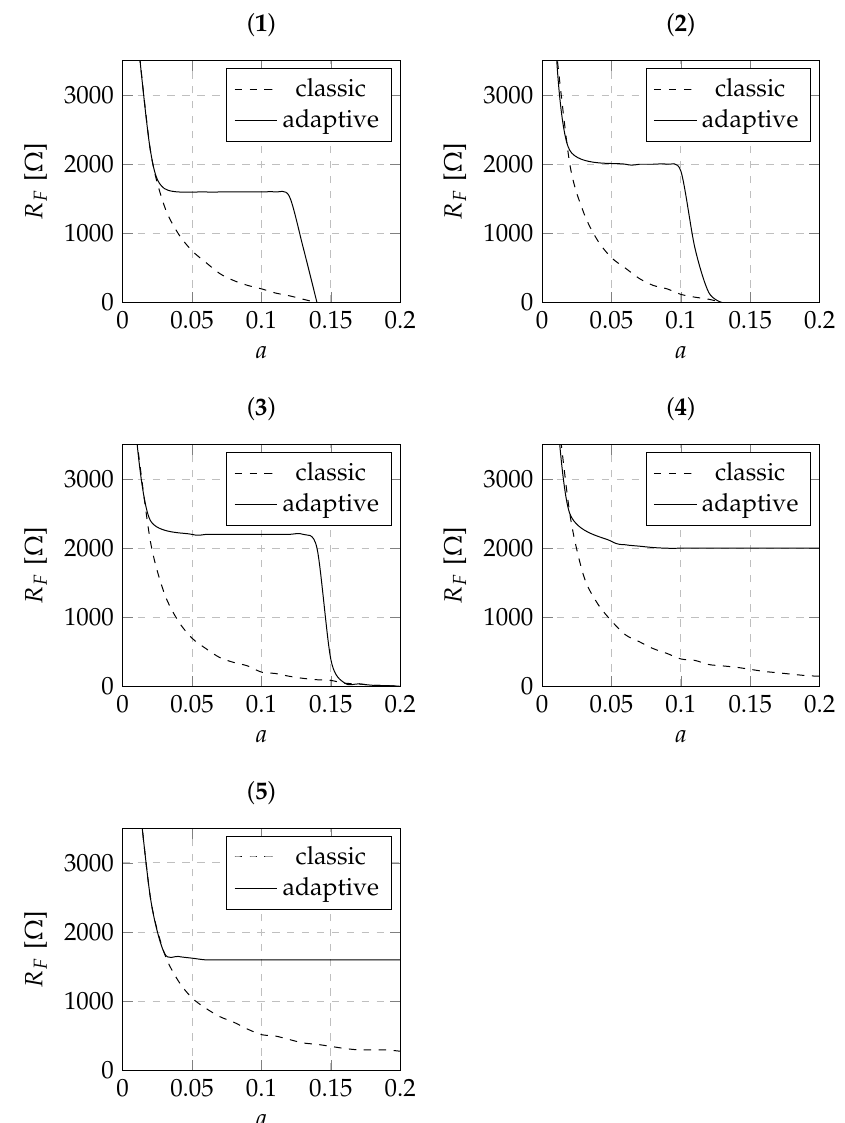
Figure 9. Comparison of detected transition resistances R F for overcurrent protections operating with the classical zero-sequence current algorithm and the adaptive algorithm for different values of s : ( 1 ) s = − 0.2, ( 2 ) s = − 0.1, ( 3 ) s = 0, ( 4 ) s = 0.1, ( 5 ) s =